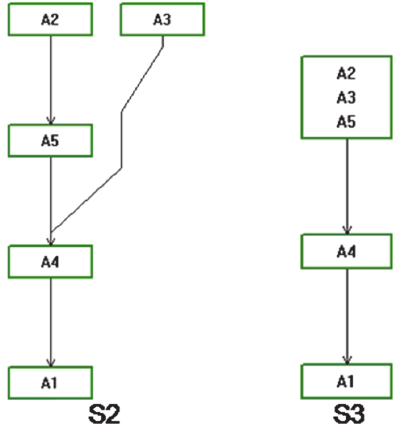
Fig. 6. Scenarios for variation of veto